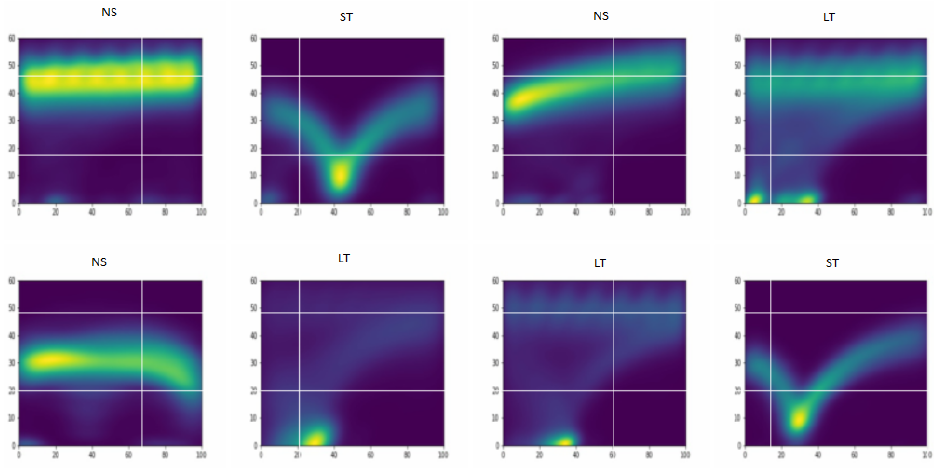
Figure 7. Examples of kernel density images for the method of